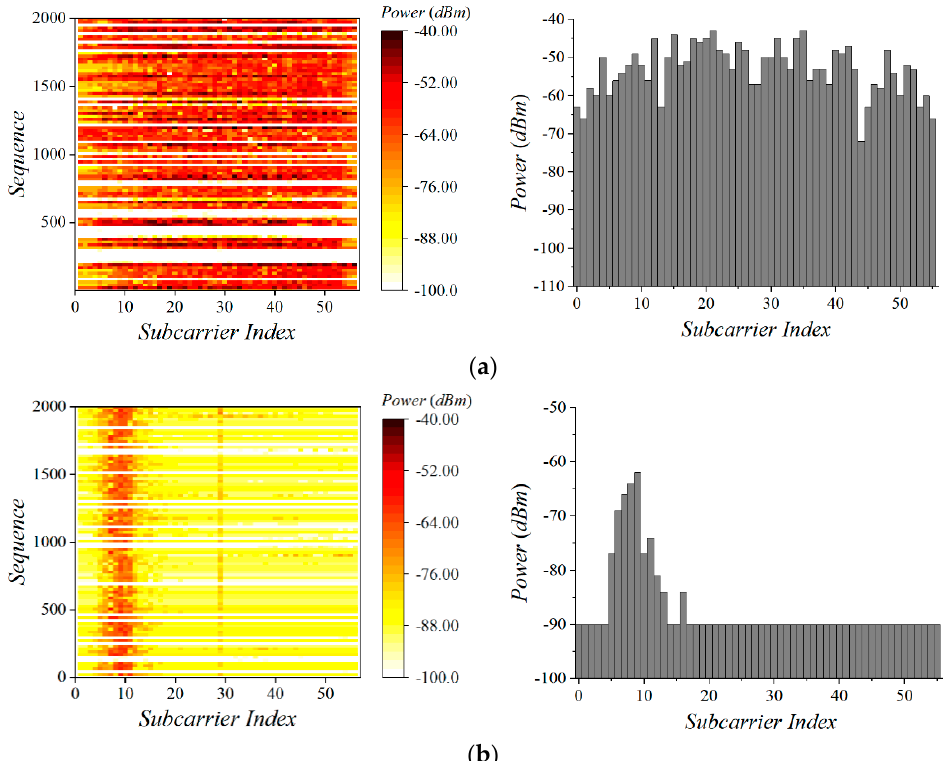
Figure 3. Monitored absolute magnitude of Wi − Fi and Zigbee traffic at the Wi − Fi AP. ( a ) Wi − Fi traffic, ( b ) Zigbee traffic.